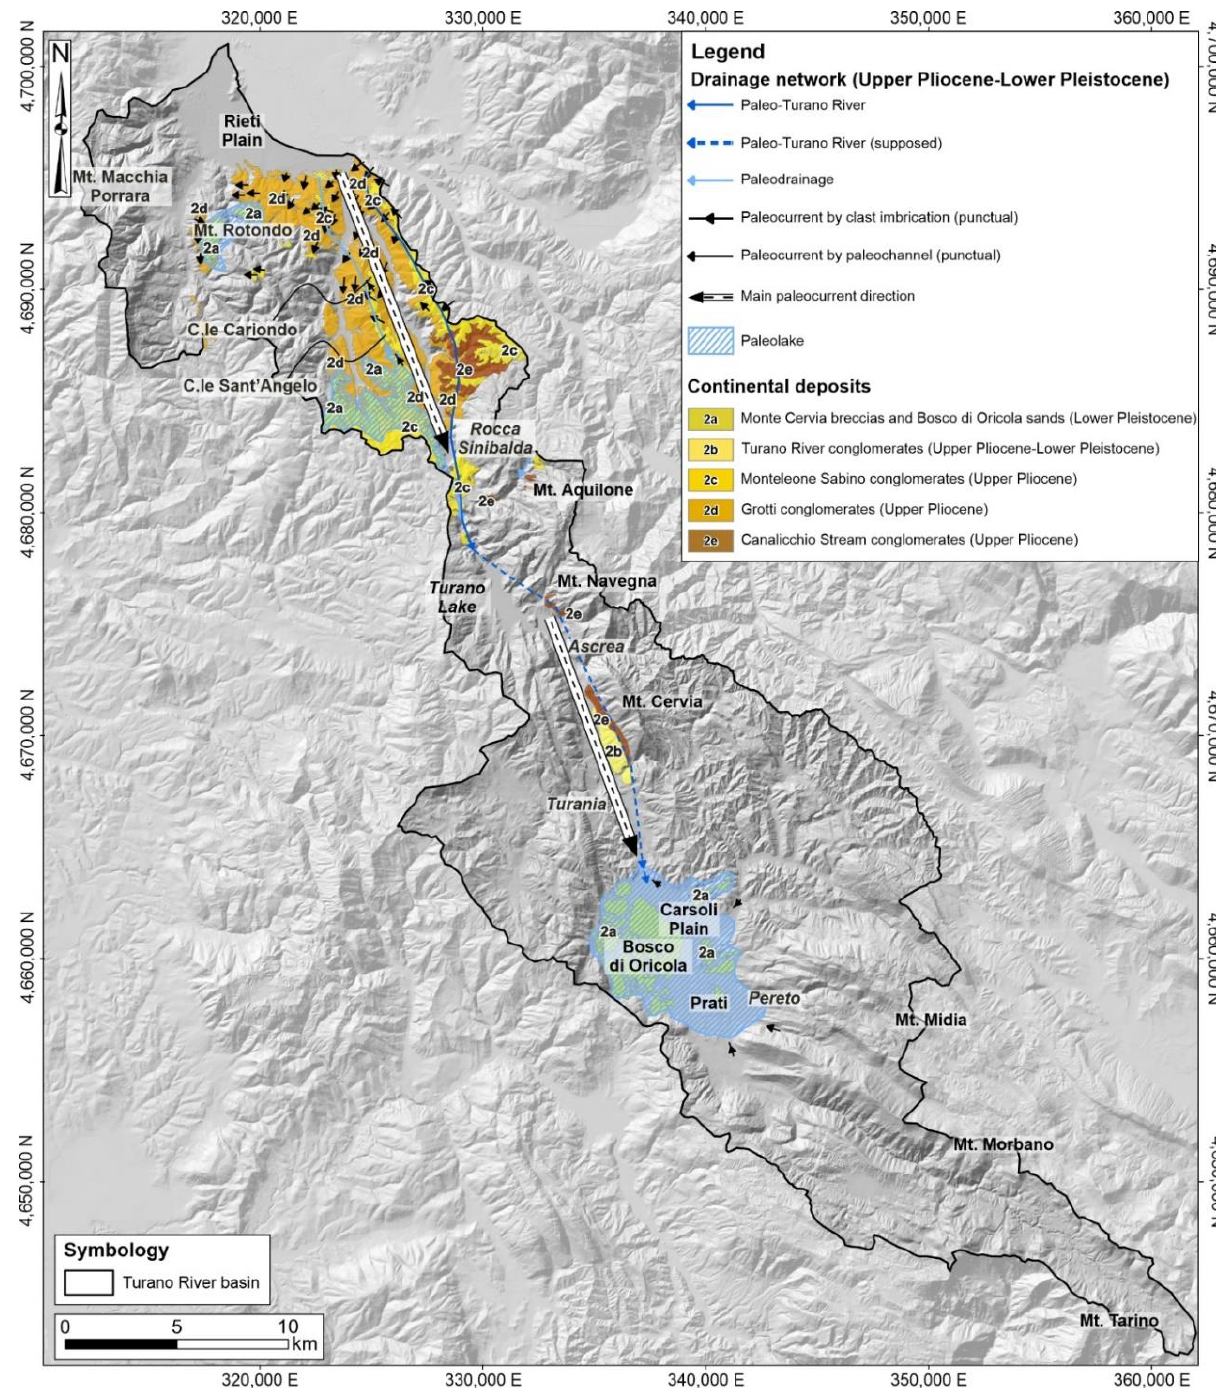
Figure 7. Drainage network of the Turano River from Upper Pliocene to Lower Pleistocene, mainly dominated by a NE-SW-oriented paleo-drainage.